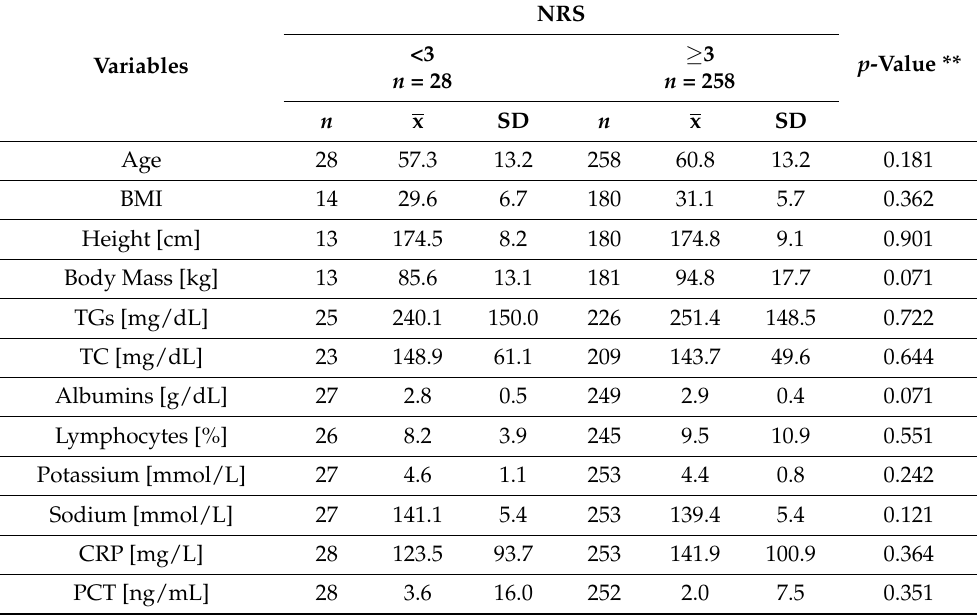
Table 5. Comparison of assessed parameters (quantitative variables) and NRS